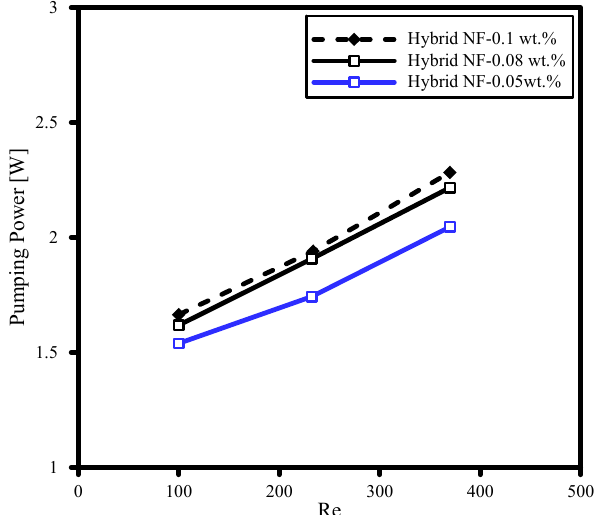
Figure 16. Pressure drop of FPSC with water-based (hBN/CF-CNTs) nanofluid for various Reynolds numbers at 960 W/m 2 and inlet temperature 30 °C.